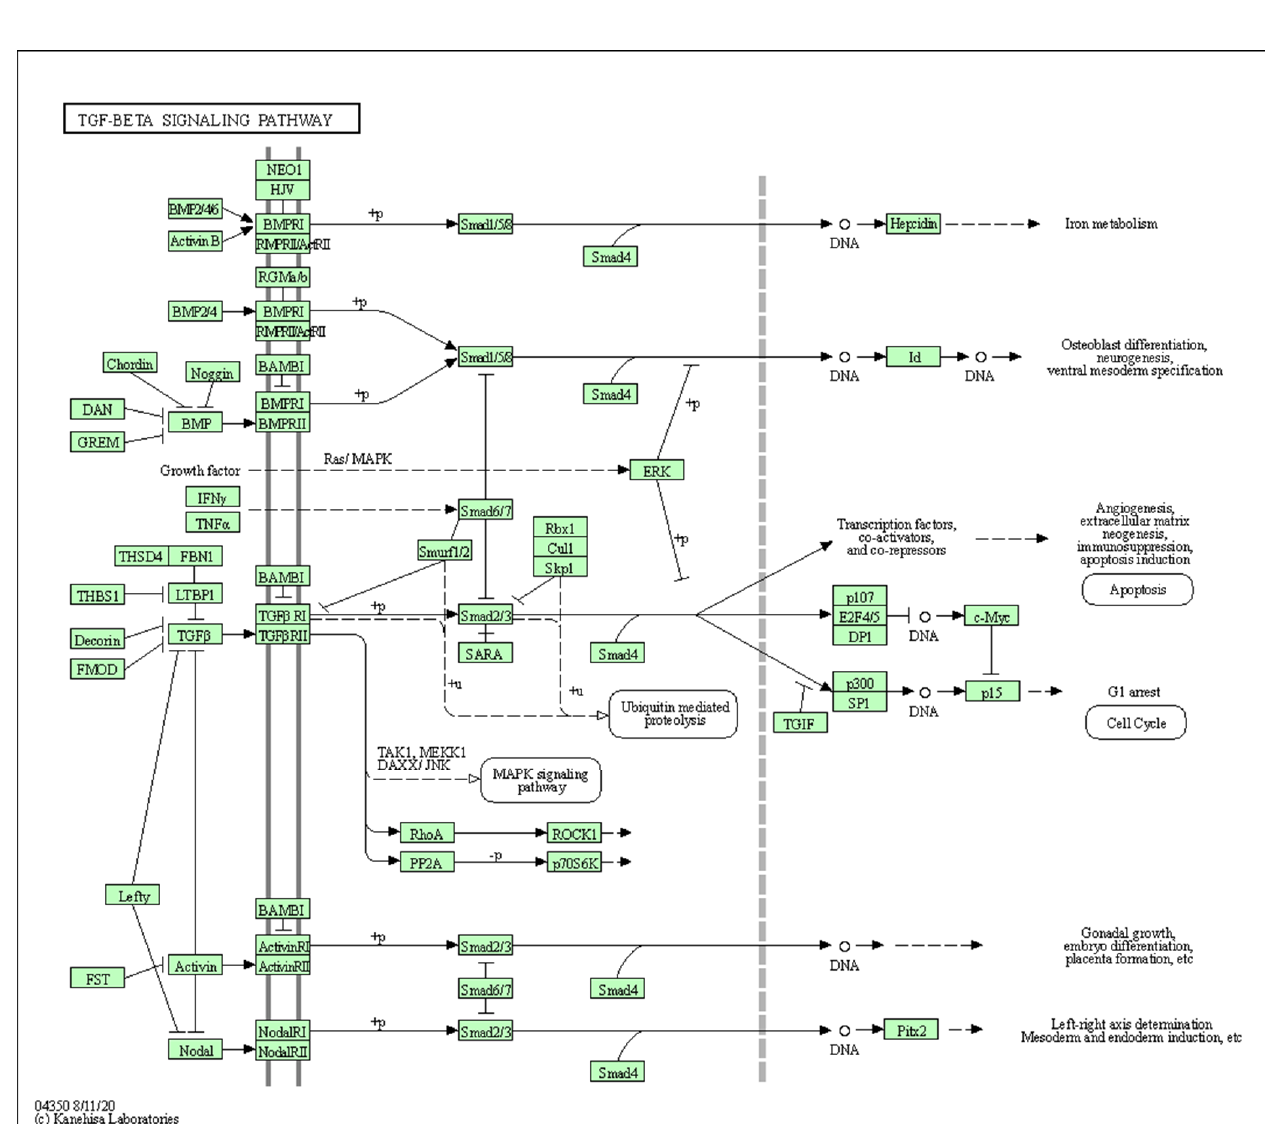
Figure A1. TGF- β signaling pathway, KEGG pathway. KEGG, Kyoto Encyclopedia of Genes and Genomes. Copyright permission obtained.